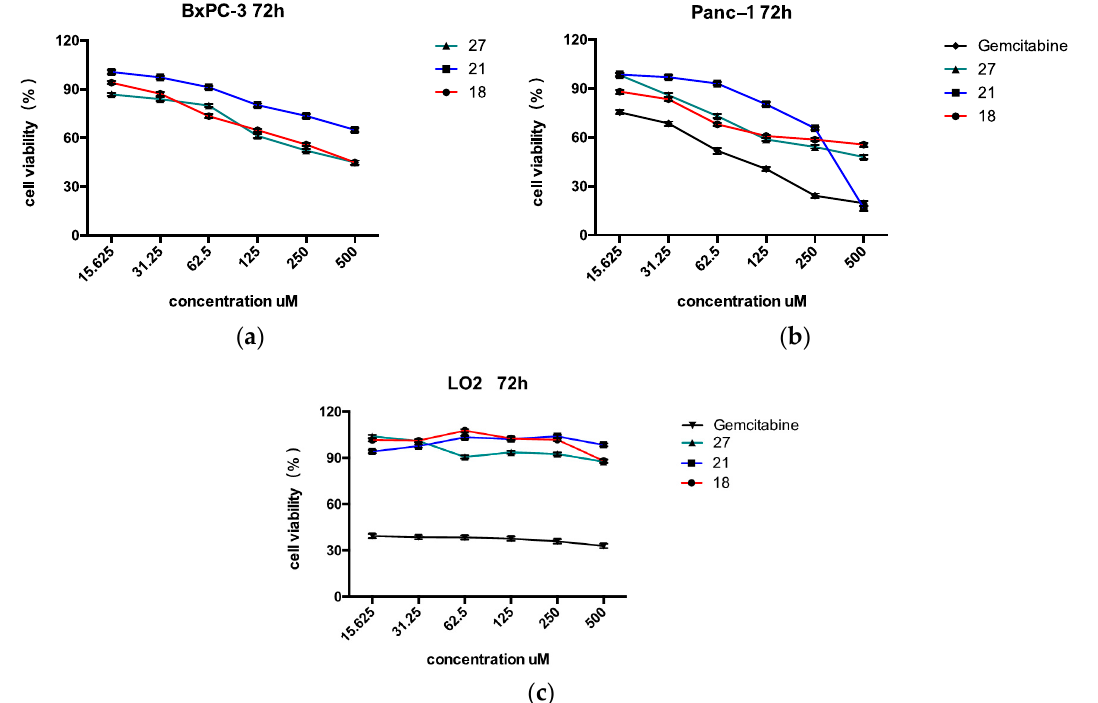
Figure 3. Anti-pancreatic cancer activity and cytotoxicity test of oligosaccharides 18 , 21 , and 27 . BxPC- 3 ( a ), PANC-1 cells ( b ) were treated with compounds 18 , 21 , 27 , and gemcitabine (as a positive control) at concentrations of 15.625, 31.24, 62.5, 125, 250, and 500 μ M for 72 h followed by MTT test. LO2 cells ( c ) were treated with compounds 18 , 21 , 27 at concentrations of 15.625, 31.24, 62.5, 125, 250, and 500 µ M for 72 h followed by MTT test.